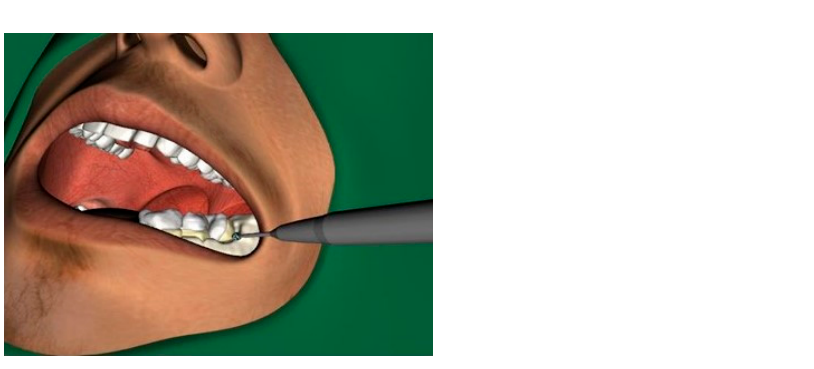
Figure 4. The virtual intraoperative situation while drilling to remove a wisdom tooth in the left lower jaw.